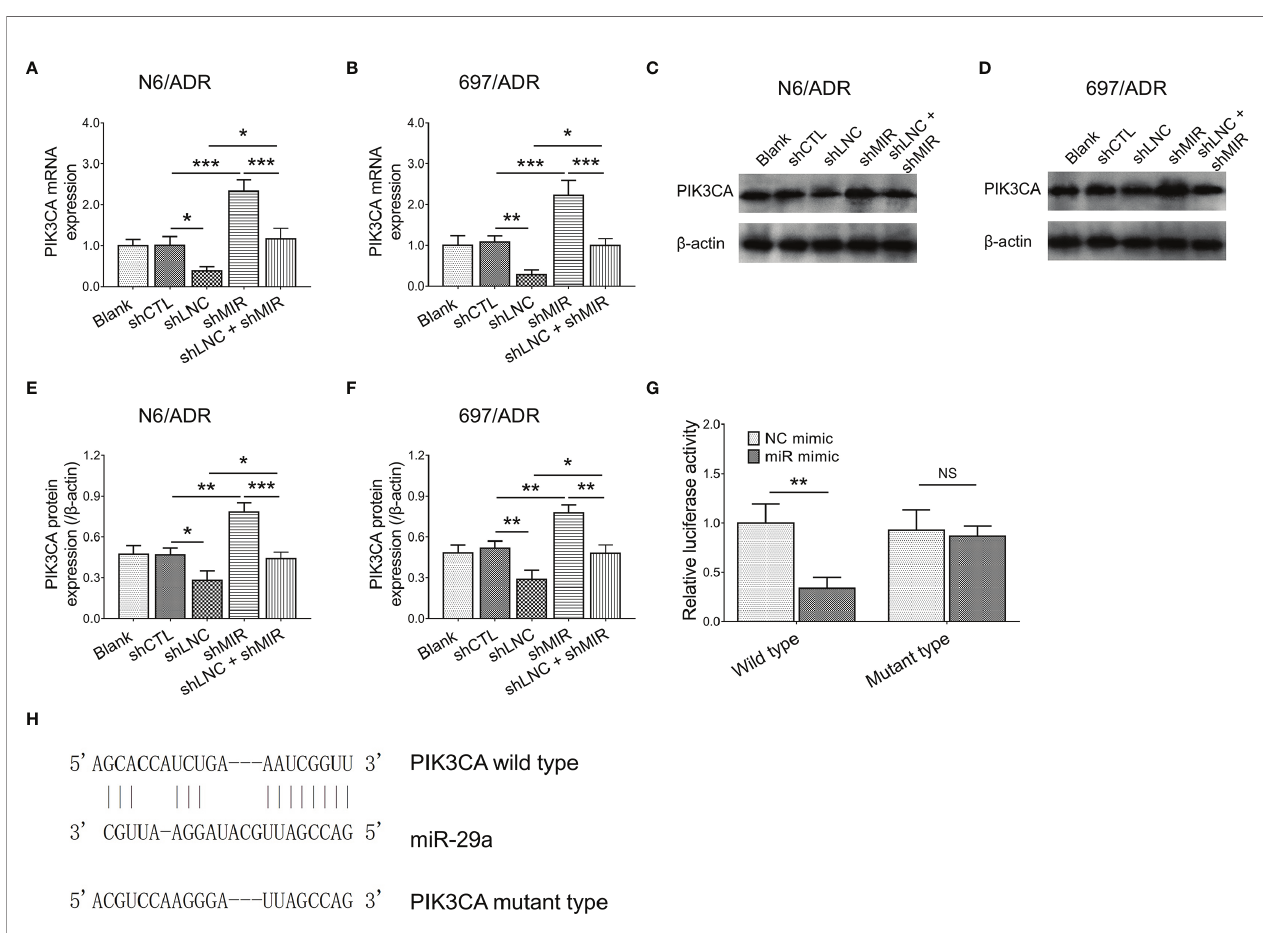
FIGURE 6 | Interaction among lncRNA DUXAP8, miR-29a, and PIK3CA . PIK3CA expression among blank, shCTL, shLNC, shMIR, and shLNC +shMIR groups in N6/ADR cells and 697/ADR cells (A – F) . Luciferase reporter gene assay results (G) and binding site between miR-29a and PIK3CA (H)